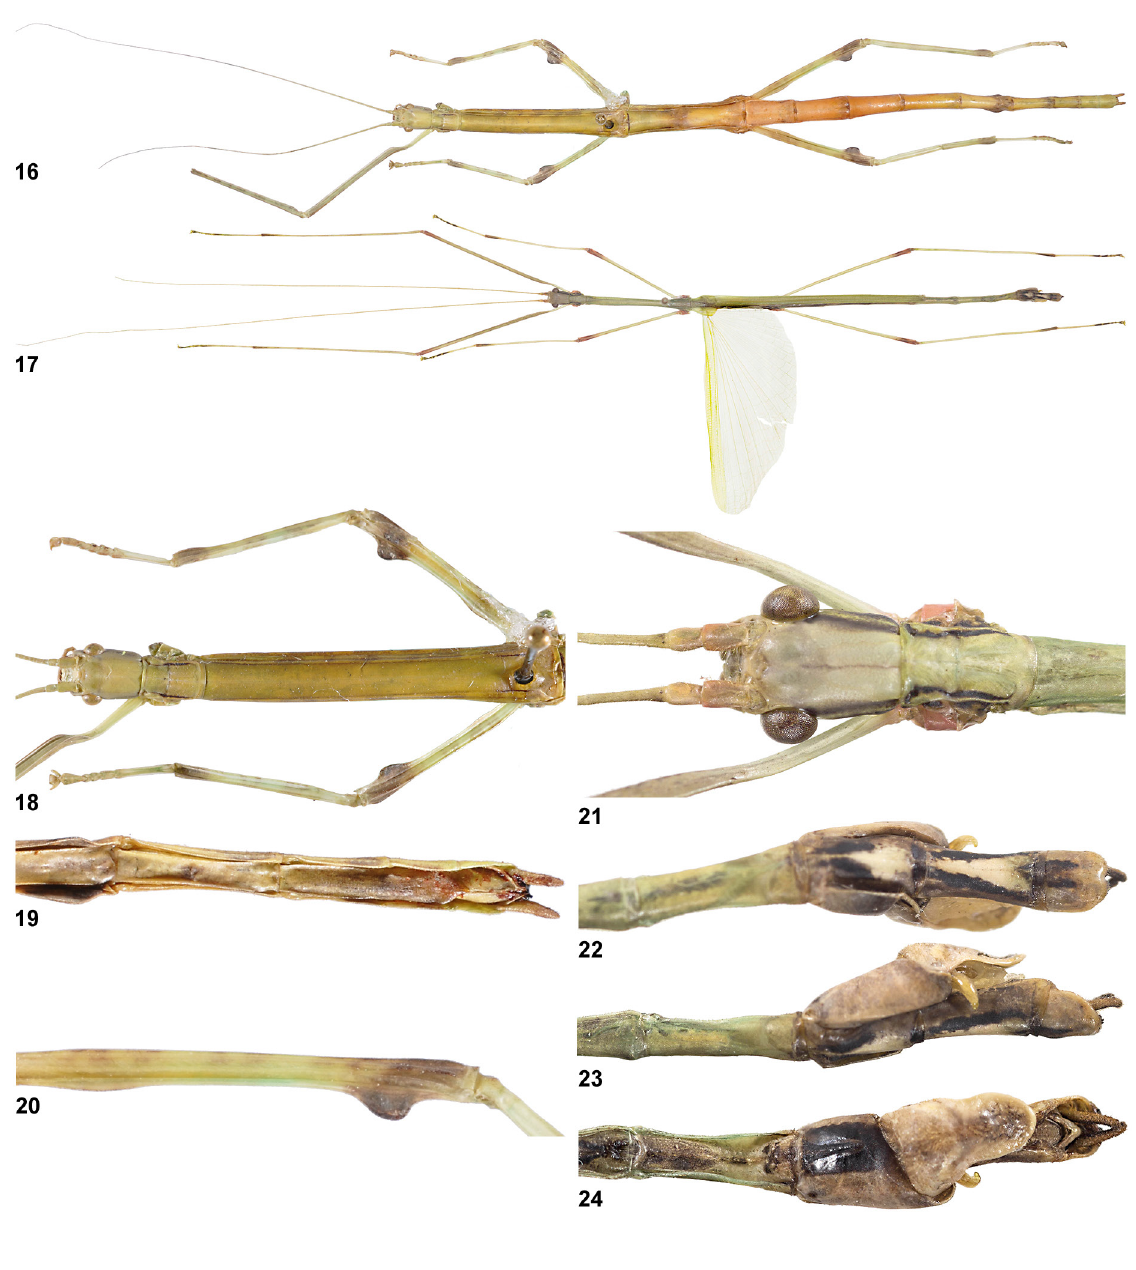
Figs 16–24. Phantasca femorata sp. nov. 16 . Holotype, ♀, habitus, dorsal view. 17 . Paratype, ♂ , habitus, dorsal view. 18 . Holotype, ♀, head, pro- and mesothorax, dorsal view. 19 . Holotype, ♀, apex of abdomen, ventral view. 20 . Holotype, ♀, left mesofemur, anterior view. 21 . Paratype, ♂, head and pronotum, dorsal view. 22 . Paratype, ♂, apex of abdomen, dorsal view. 23 . Paratype, ♂ , apex of abdomen, lateral view. 24 . Paratype, ♂, apex of abdomen, ventral